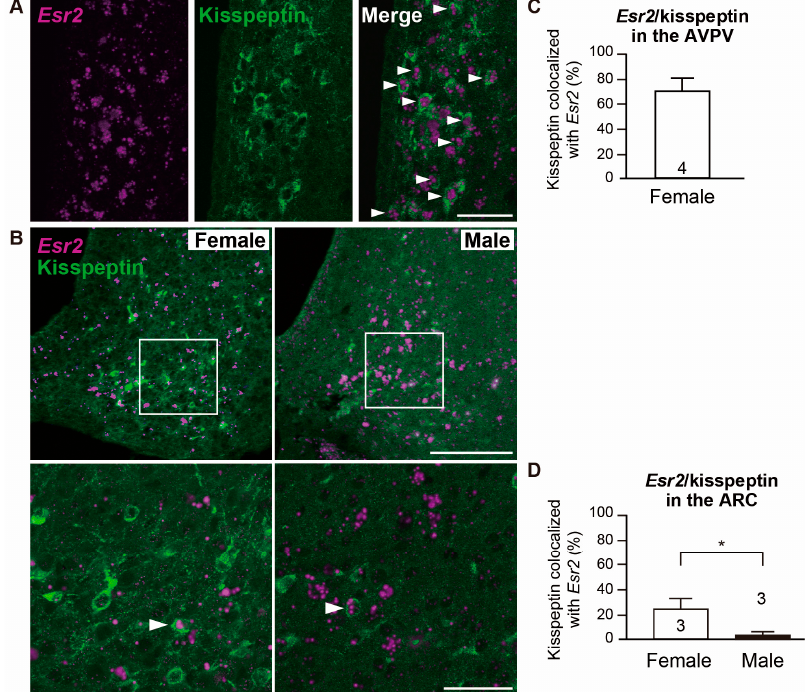
Figure 2. Co-expression of Esr2 and kisspeptin in the anteroventral periventricular nucleus (AVPV) and arcuate nucleus (ARC). Representative photomicrographs show dual labeling of Esr2 mRNA (magenta) and kisspeptin (green) in the AVPV of female rat ( A ) and ARC of both sexes ( B ). High magnification images (the bottom lower images) correspond to the boxed areas in the overviews. Arrowheads indicate double-labeled cells. Scale bars measure 50 µ m in A, and 200 µ m in the low magnification, and 50 µ m in the high magnification in B. The percent of kisspeptin-ir cells co-expressed with Esr2 mRNA in the AVPV ( C ) and ARC ( D ). Values are depicted as the mean ± SEM. Numbers in each column represent the number of animals used. * p < 0.05.